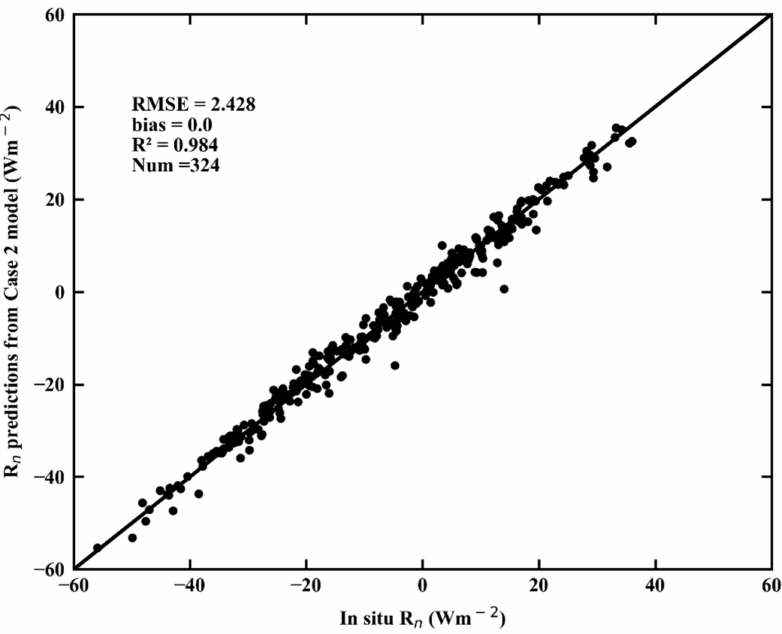
Figure 10. Fitting accuracy of the Case 2 model (Equation